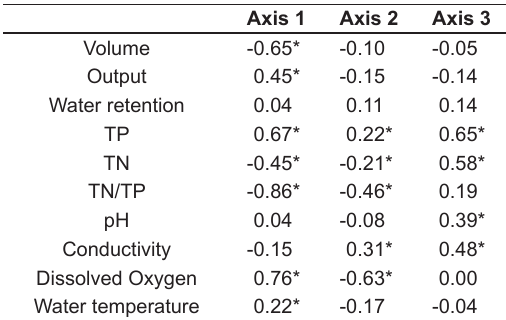
Figure 4. Principal Components Analysis (PCA) of abiotic variables (Cond. = conductivity; NT= total nitrogen; pH= hydrogen potential; PT= total phosphorus; Runoff = Output; Water retention= residence time; Vol. = volume; O2= dissolved oxygen; NT.PT= ratio of Total Nitrogen e Total Phosphorus) at Armando Ribeiro Gonçalves Reservoir from April 2009 to October 2011. (figure codes follow the order: month, year, point (I= Itajá; S= San Rafael), Zone (A for aphotic and F for photic). Table 3. Correlation coefficients between abiotic variables and the three PCA first axes.